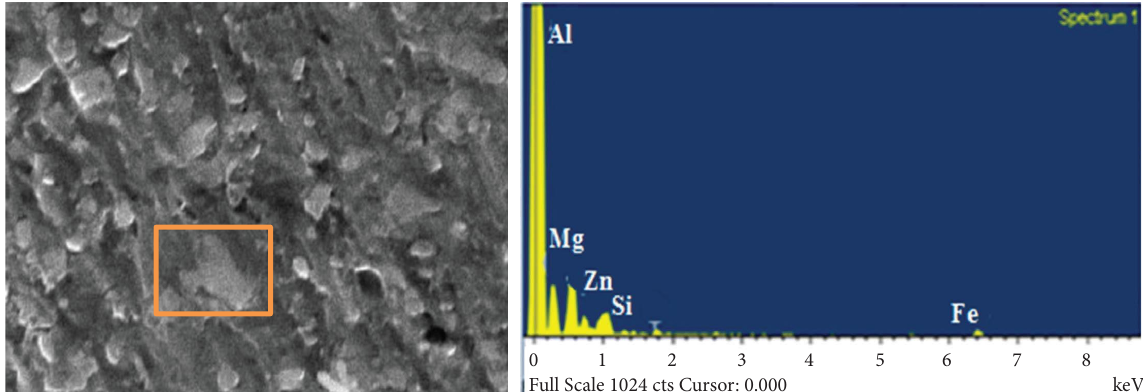
Figure 13: EDX analysis of experiment no. 12 machined